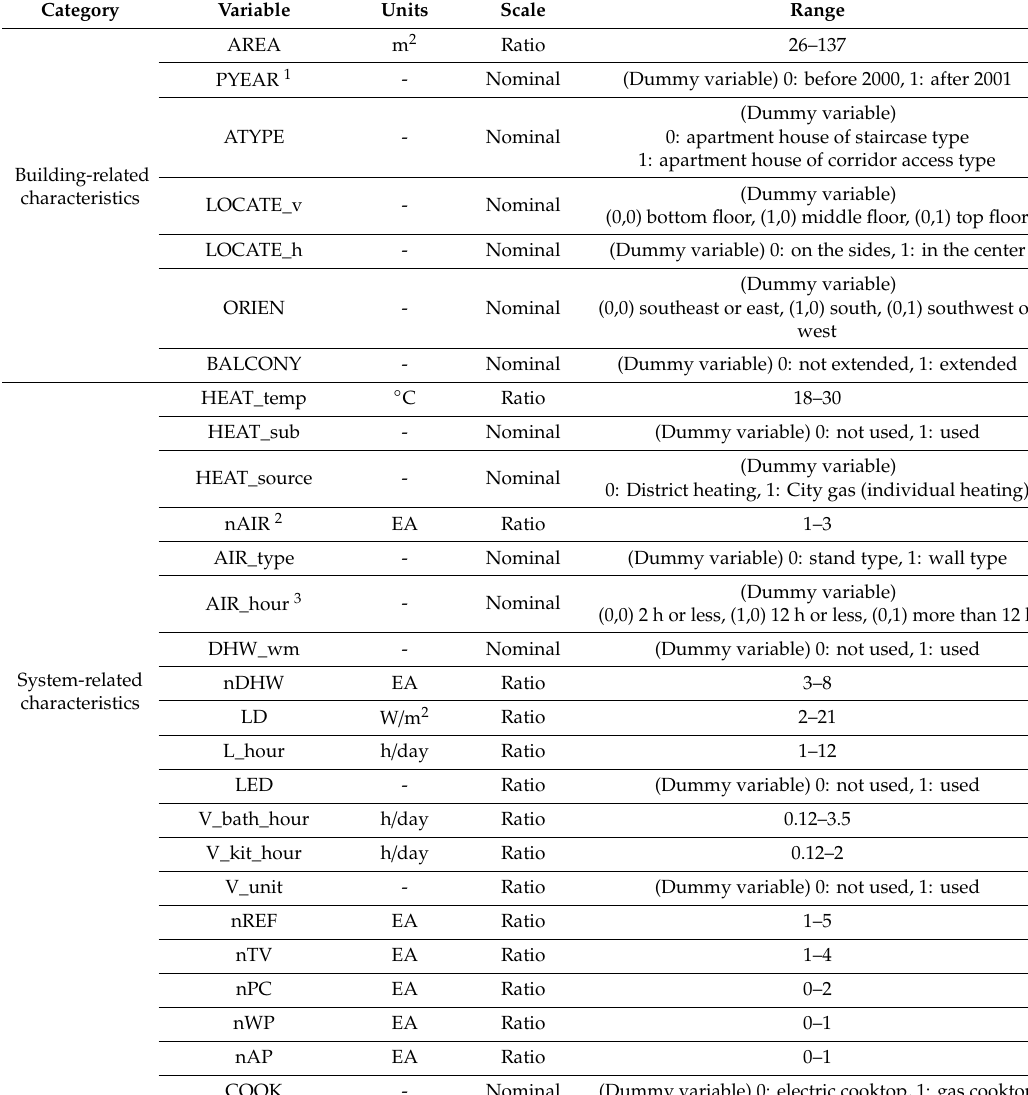
Table 1. Independent-variable